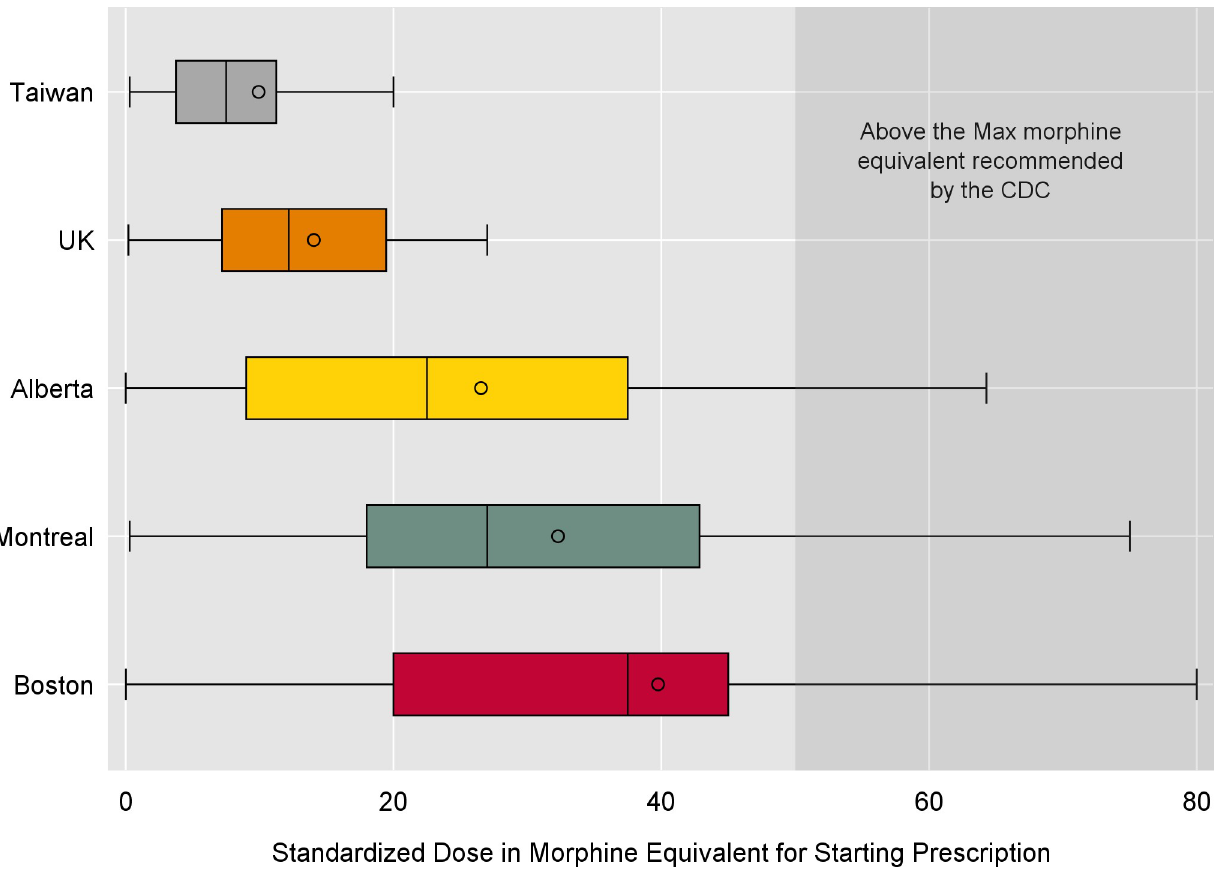
Fig 2. Daily dose of first opioid prescription in MMEs. The lower limit of the box plot represents the lowest standardized dose, the lower and upper ends of the colored box the interquartile range, the line in the box represents the median, and the circle the mean standardized dose. For this box plot, the upper limit of the box plot is set to the 95th percentile. CDC AU : AnabbreviationlisthasbeencompiledforthoseusedinFig 2 : Pleaseverifythatallentriesarecorrect : , Centers for Disease Control and Prevention; MME, morphine milligram equivalent.